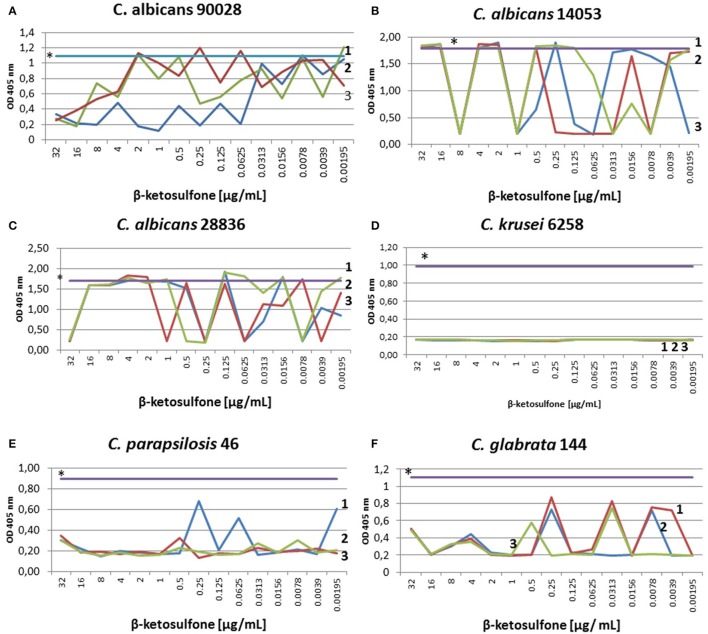
Characterization of growth of Candida strains in the presence of compound 4. Optical densities at 405 nm were obtained after treatment with different compound 4 concentrations. Control susceptibility test of compound 4 after 48 h against reference strains: C. albicans 90028 (A), C. albicans 14053 (B), C. albicans 28836 (C), C. krusei 6258 (D). Susceptibility test against the clinical strains: C. parapsilosis 46 (E) and C. glabrata 144 (F). Testing antifungal susceptibility to compound 4 was performed as described in Materials and Methods after 48 h. Test was performed in 3 independent experiments. Results are presented as follows: *growth control in RPMI with DMSO dissolved in water (0.66% v/v); 1, 2, 3 stand for three independent susceptibility tests. (A) The 48-h incubation with compound 4 yielded significantly reduced OD of 90028 at concentrations ranging from 16 to 32 μg/mL. No paradoxical growth in the presence of agent in C. albicans 90028 was noted. (B) Optical densities obtained after 48 h of incubation of C. albicans 14053 indicated paradoxical effect. The graph showed significantly decreased OD at 8 μg/mL, which correspond to 9-log reduction of cfu of C. albicans 14053 (Table 4). (C) The curves of ODs of C. albicans 28836 plotted against compound 4 concentrations showed higher starting OD and a steeper decrease in the slope of the curve at 32 μg/mL, which correspond to 10-log reduction (Table 4). (D) As determined by optical density, dramatically reduced viability of cells of C. krusei 6258 after exposure to compound 4 relative to the control grown in the presence of DMSO (0.66%) was seen. (E)
C. parapsilosis 46 cells reduction after exposure to compound 4 correlated with end point at 8 and 1 μg/mL (Table 3), and 4-log reduction at concentrations ranging from 16 to 2 μg/mL (Table 4). Paradoxical growth in C. krusei 46 was noted. (F) Growth of cells of C. glabrata 144 incubated in the presence of 0.0156 μg/mL of compound 4 was significantly reduced, which corresponded to MIC (Table 3) and elevated reduction of cell growth (ranging from 4- to 10-log reduction at 8 and 16 μg/mL, respectively, Table 4).